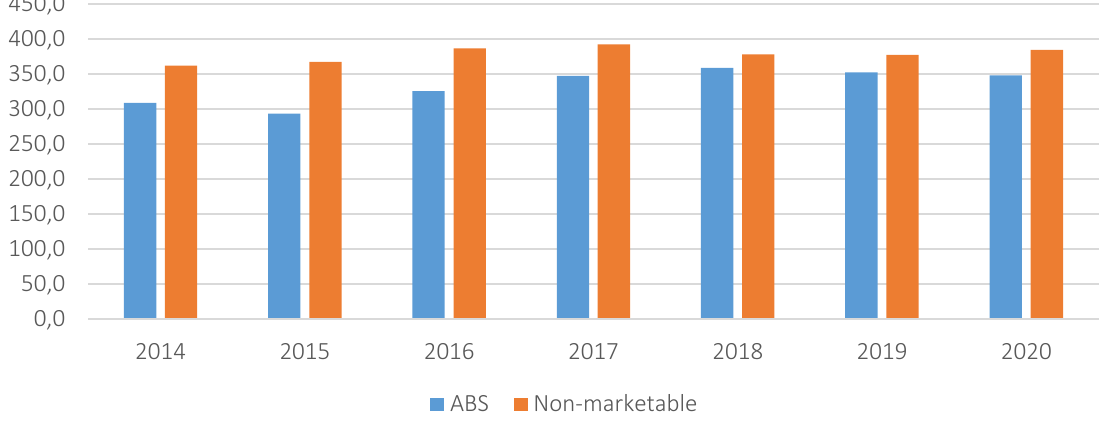
Figure A2. Assets pledged in the Euro Area (Billions of euros, end-month average) Table A1. Loans to Italian SMEs and